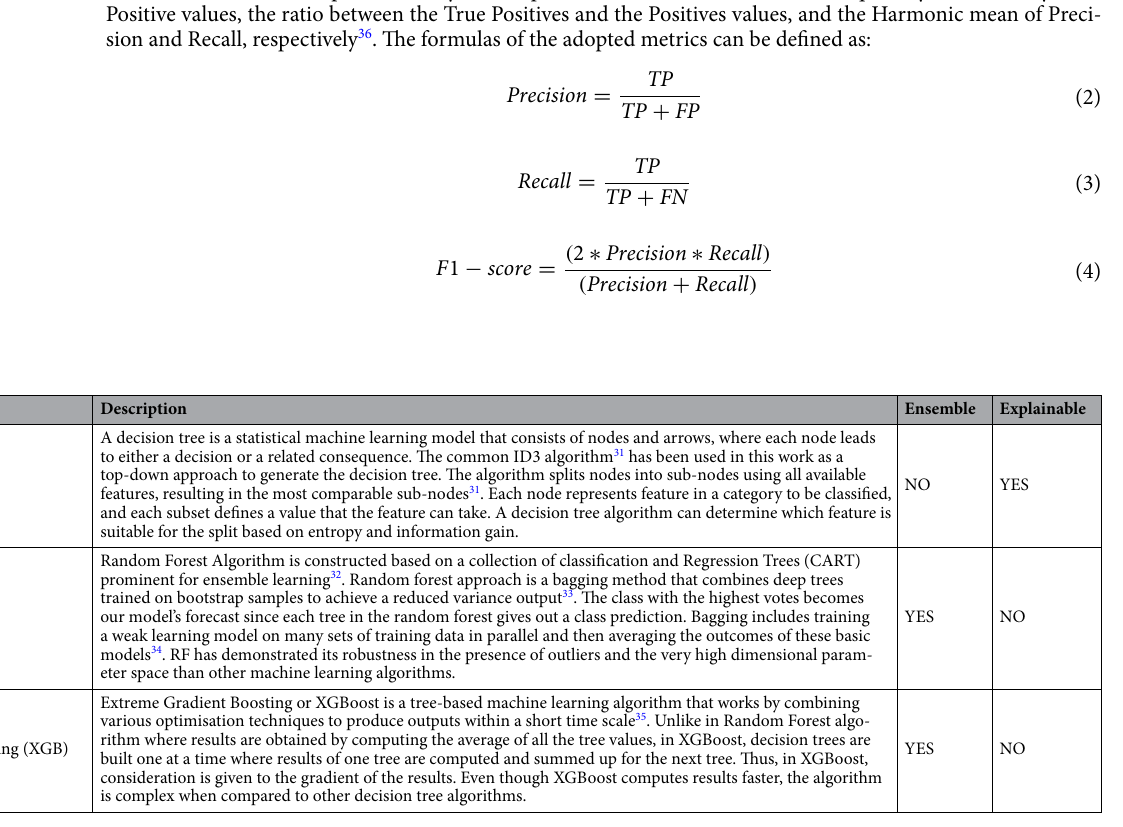
Table 1. A brief description of the machine learning models adopted in this